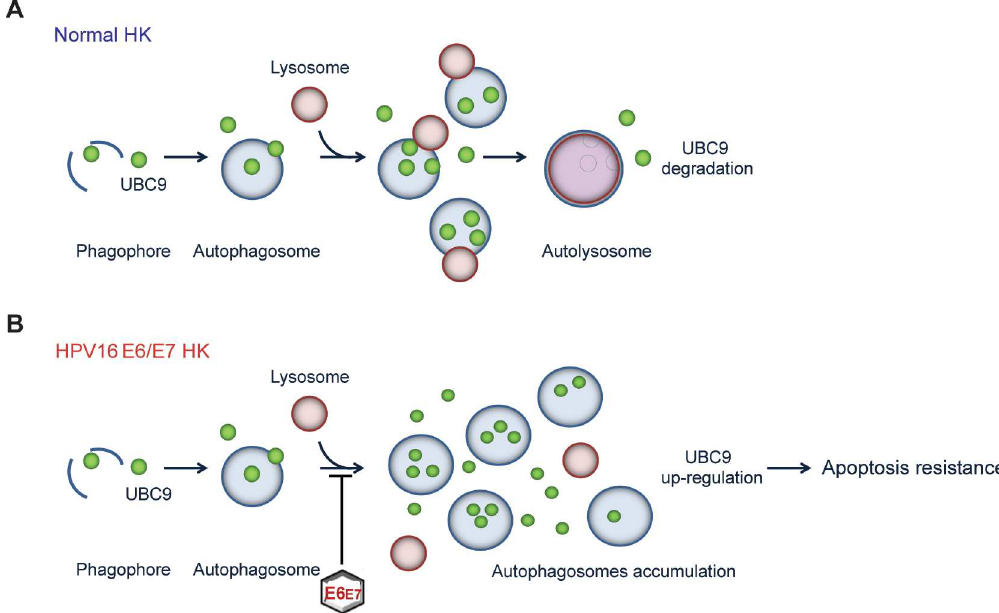
Fig 11. Model of autophagic-mediated UBC9 degradation and its impairment by HPV16 E6/E7 in HKs. (A) In normalconditions, UBC9 protein expressionis retainedat physiological levels by basal autophagy in HKs. (B)